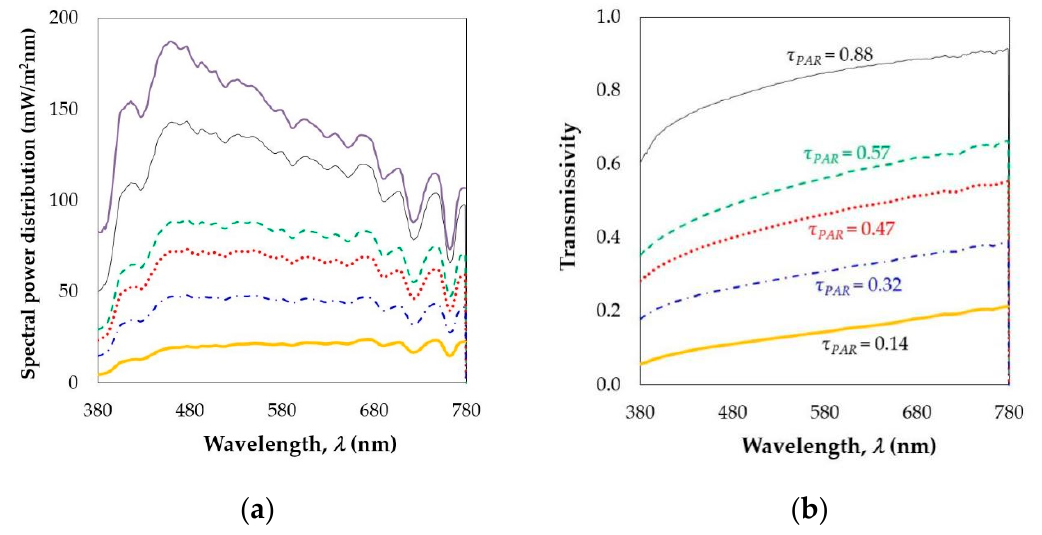
Figure 1. Spectral power distribution ( a ) and transmissivity ( b ) of sun light ( ▬ ), light transmitted by a plastic cover without whitening (––) and with whitening for doses of 0.125 kg L −1 and 15.7 g m −2 ( - - - ), 0.250 kg L −1 and 23.7 g m −2 (·····), 0.500 kg L −1 and 34.6 g m −2 ( -·-·- ), 1 kg L −1 and 108 g m −2 ( ▬ ).